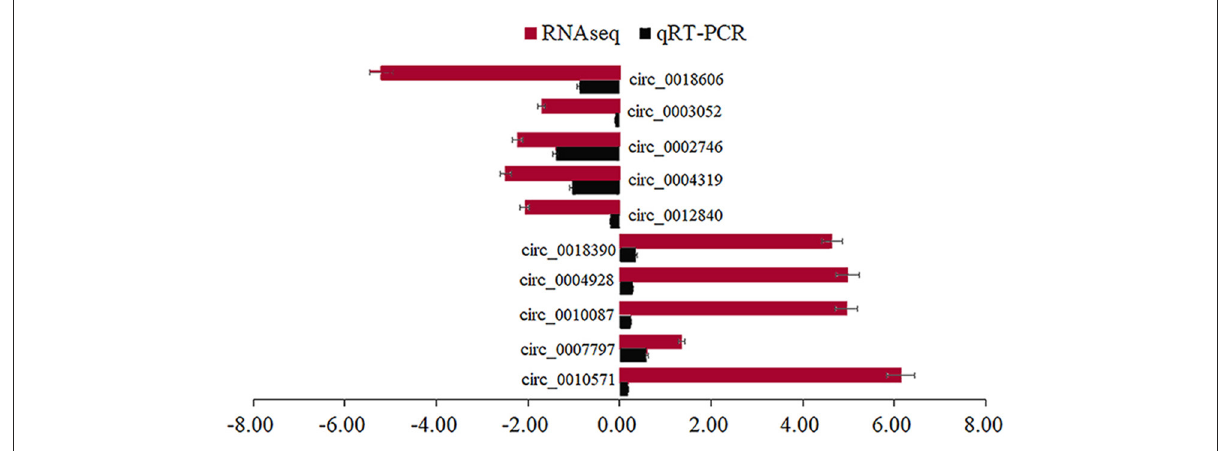
FIGURE5 Different circRNAs verified using RT-qPCR.